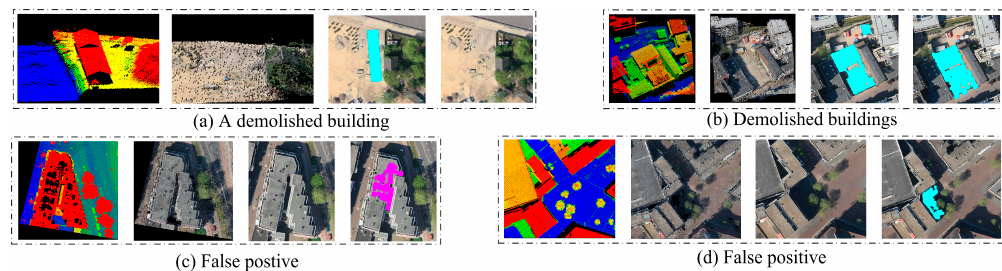
Figure 13. Six examples of the building detection results for Enschede data.